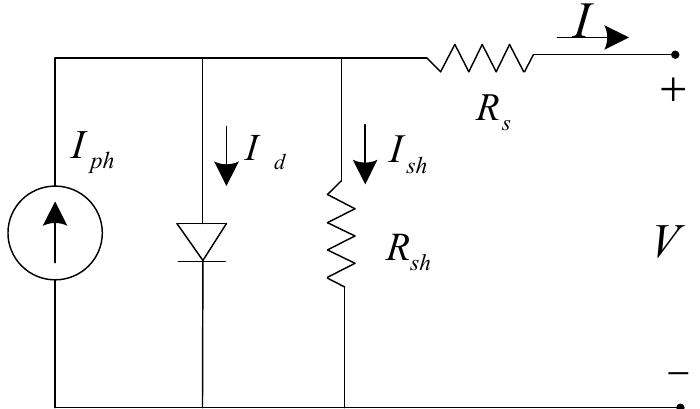
Figure 8. Theoretical circuit model of the PV converter.